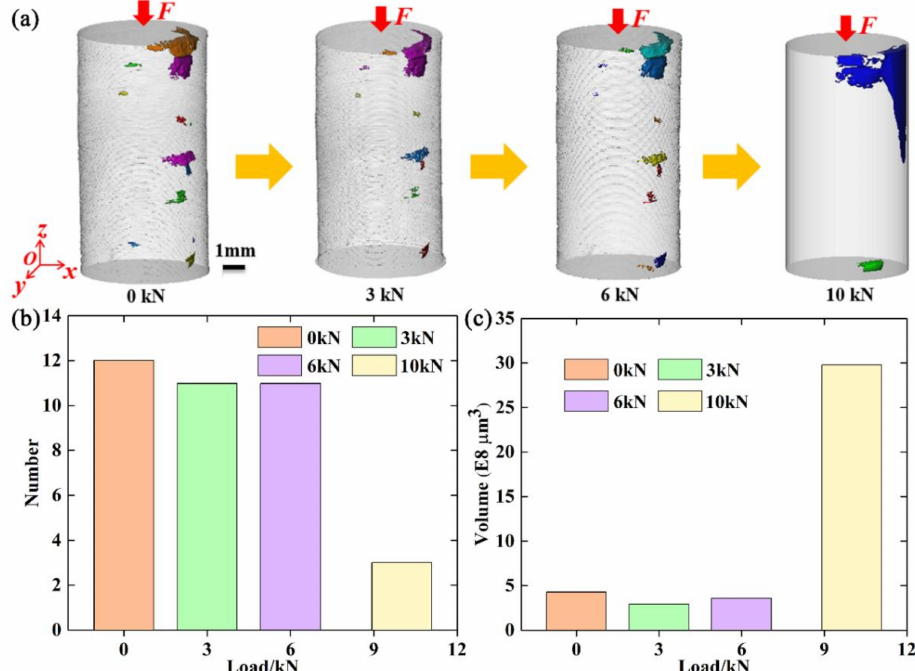
Figure 7. ( a – c ): Three-dimensional volume rendering, number, and volume, respectively, of the vertical cracks at different compressive